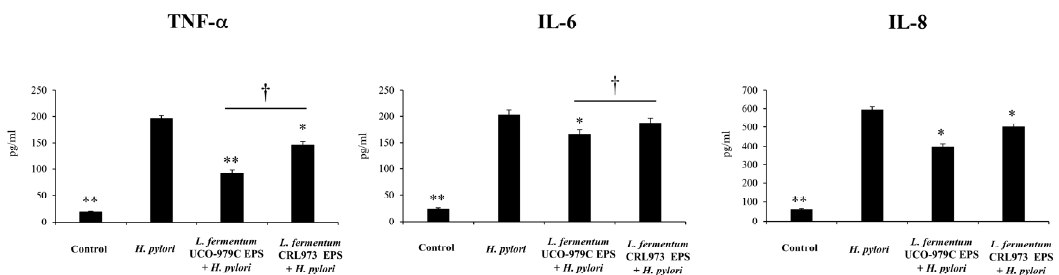
Figure 8. E ff ect of Lactobacillus fermentum UCO-979C or L. fermentum CRL973 EPS on the cytokine and chemokine production of human gastric epithelial cells (AGS cells) after Helicobacter pylori challenge. AGS cells were incubated with 100 µ g / mL of L. fermentum UCO-979C or L. fermentum CRL973 EPS for 24 h. Then, cells were challenged with H. pylori 43504. The levels of TNF- α , IL-6, IFN- γ and IL-10 (pg / mL) in culture supernatants were determined 24 h after infection. Results represent data from three independent experiments. Results are expressed as mean ± standard deviation. Significant di ff erences when compared to the control group: * ( p < 0.05), ** ( p < 0.01). Significant di ff erences when compared to the indicated group: † ( p < 0.05).